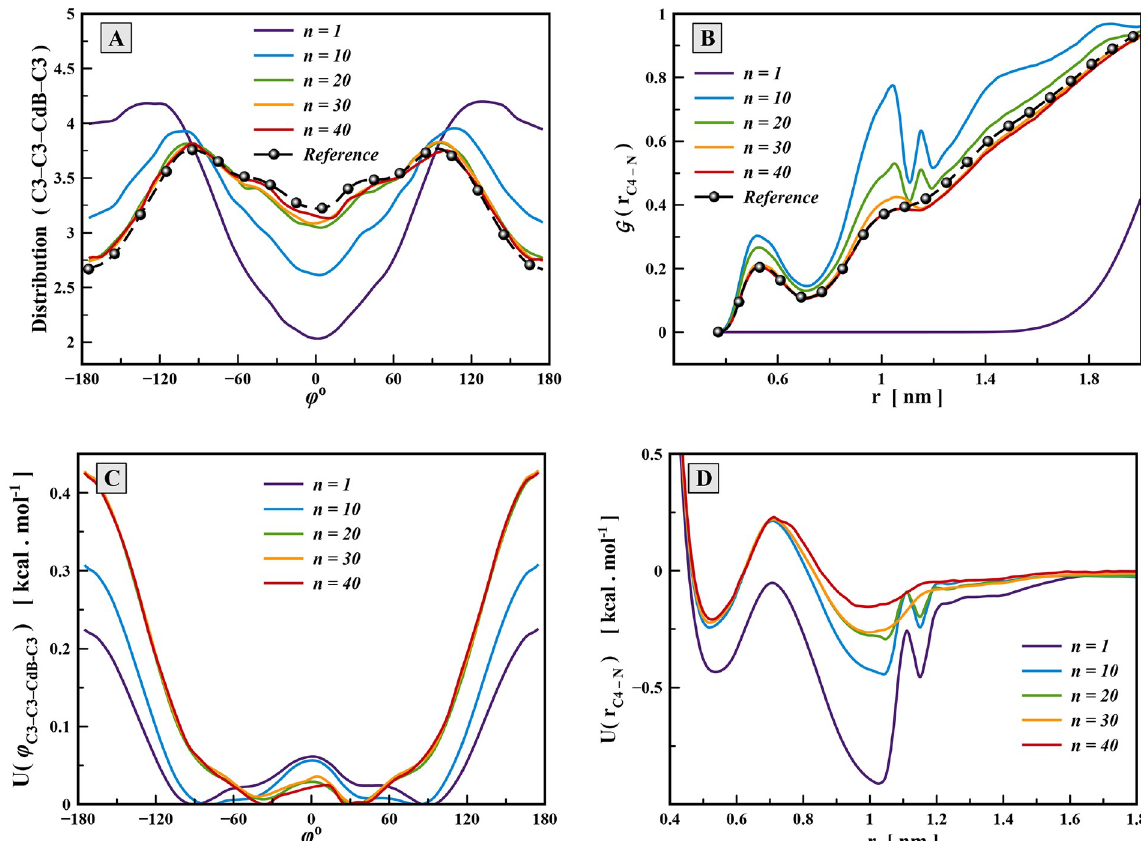
Fig 4. Two examples of convergence of CG potentials and distribution functions during the iterative process. (A) and (C) convergence of the distribution function (A) and CG potential (C) for torsion angle interaction C3-C3-CdB-C3. (B) and (D) convergence of the distribution function (B) and CG potential (D) for non-bonded interaction